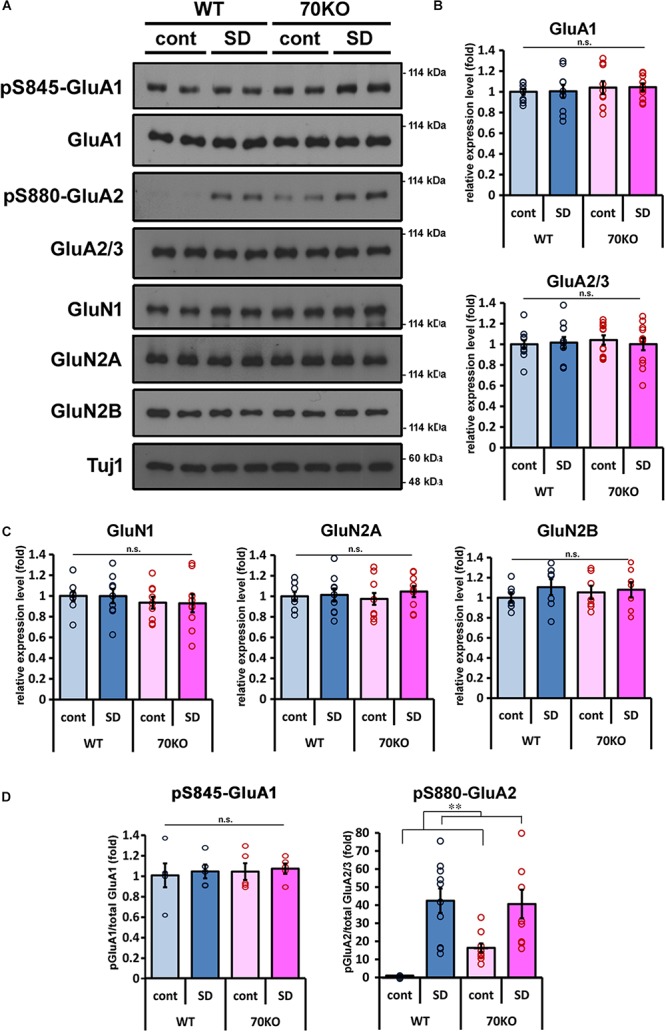
Phosphorylation level of GluA2 is elevated in response to SD stress. (A) Representative results of western blots for glutamate receptors in the mPFC (n = 7–12). (B,C) Quantification of the protein levels of AMPA-type (B) and NMDA-type (C) glutamate receptor subunits in the mPFC of WT and PSD-Zip70KO mice with or without SD stress. (GluA1, Fgene(1,39) = 0.6472, P = 0.4264, Fstress(1,39) = 0.0078, P = 0.9302, Fgene × stress(1,39) = 0.0001, P = 0.9937; GluA2/3, Fgene(1,47) = 0.0714, P = 0.7906, Fstress(1,47) = 0.0564, P = 0.8135, Fgene × stress(1,47) = 0.3116, P = 0.5795; GluN1, Fgene(1,35) = 1.0255, P = 0.3188, Fstress(1,35) = 0.0031, P = 0.9290, Fgene × stress(1,35) = 0.0010, P = 0.9746; GluN2A, Fgene(1,35) = 0.0046, P = 0.9462, Fstress(1,35) = 0.5346, P = 0.4700, Fgene × stress(1,35) = 0.2541, P = 0.6176; GluN2B, Fgene(1,27) = 0.0421, P = 0.8392, Fstress(1,27) = 0.9342, P = 0.3434, Fgene × stress(1,27) = 0.3325, P = 0.5696). (D) Quantification of the phosphorylation levels of GluA1 at Ser845 and GluA2 at Ser880 relative to the total protein, respectively (pS845 GluA1 n = 5, Fgene(1,19) = 0.1493, P = 70434, Fstress(1,19) = 0.1624, P = 0.6923, Fgene × stress(1,19) = 0.0033, P = 0.9551; pS880 GluA2 n = 10, Fgene(1,39) = 1.59999, P = 0.21404, Fstress(1,39) = 37.7901, P < 0.001, Fgene × stress(1,39) = 2.5839, P = 0.1167). All data are presented as mean ± S.E.M. ∗∗P < 0.01; n.s., not significant.